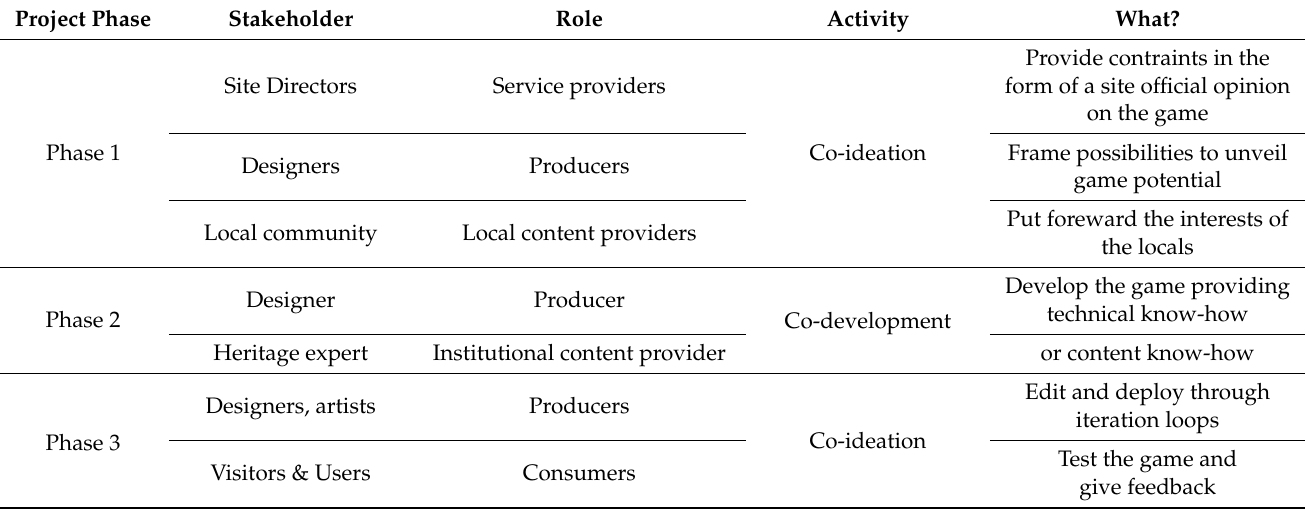
Table 3. Contributors to the development of The